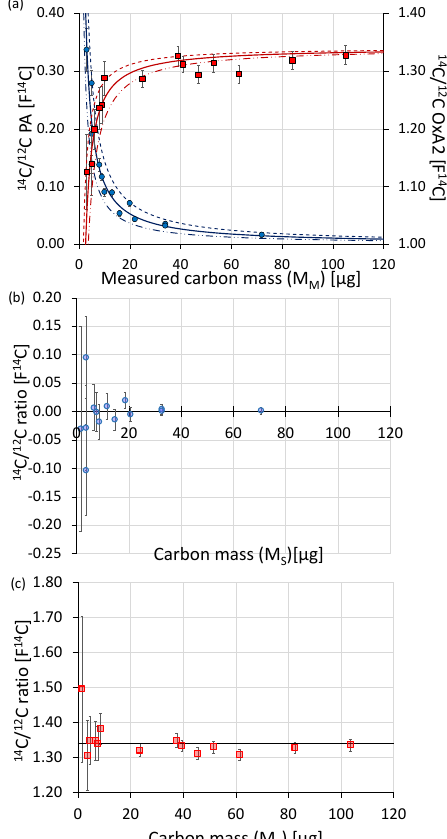
Figure 1. Measurements and corrections for blank (phthalic acid, PA) and standard (oxalic acid 2, OxA2) samples. (a) Blue dots represent the measured 14 C / 12 C ratio for sample blanks and red squares stand for standard measurements. Solid lines and dashed lines represent the least square optimization with its 95% confi- dence interval. M M is the measured carbon mass. (b) Blue dots are the corrected blank measurements. M S is the sample carbon mass (i.e., the measured carbon mass corrected for the contaminant car- bon mass). (c) Red squares are the corrected standard measurements and the line at 1.3406 stands for the certified value of OxA2. M S is the sample carbon mass (i.e., the measured carbon mass corrected for the contaminant carbon mass). The results shown in (b) (blank) and (c) (standard) illustrate the quality of the